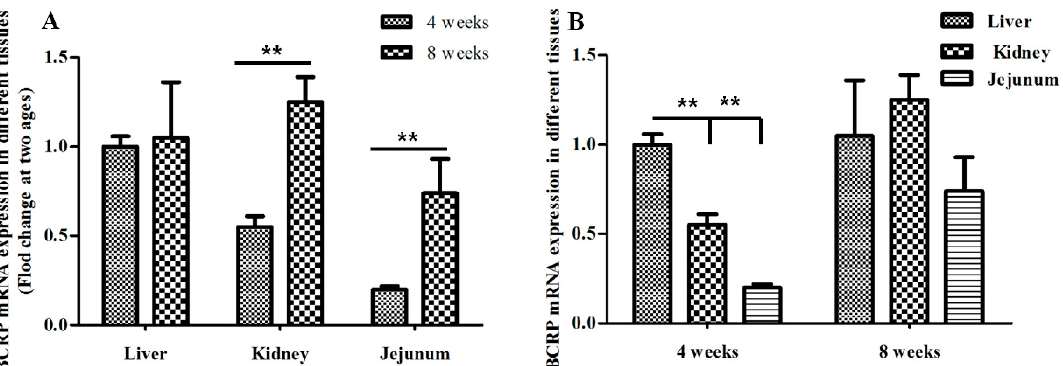
Figure 4. Comparison of the BCRP mRNA level in different tissues in broilers at different ages. ( A ) Comparison of the BCRP mRNA levels in same tissues in broilers at different ages. ( B ) Comparison of the BCRP mRNA levels in different tissues in 4- and 8-week old broilers. Data are represented as mean ± SD ( n = 5). ** p < 0.01.